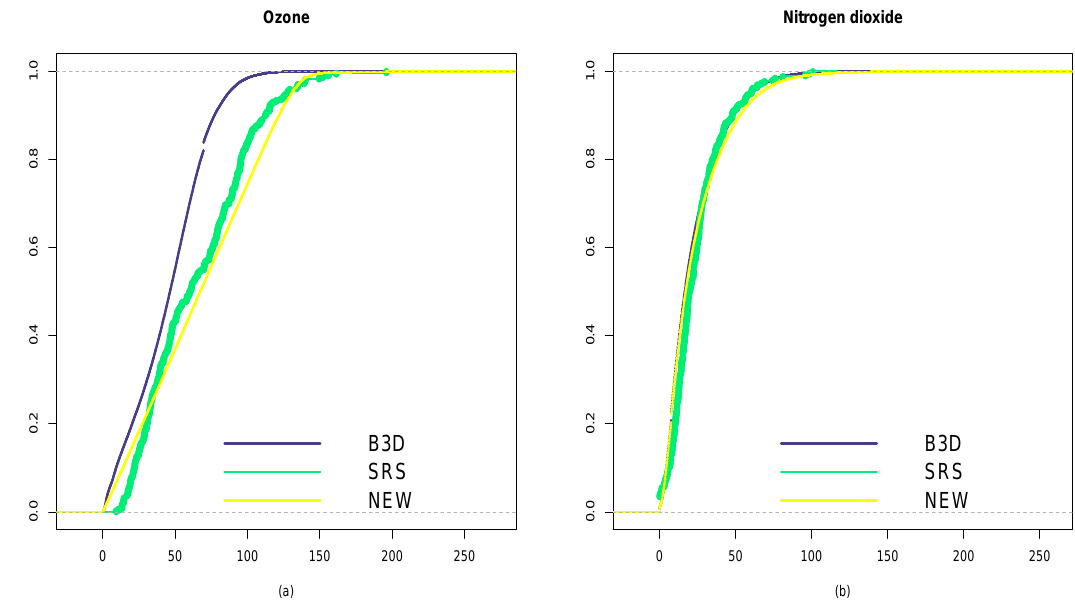
Figure 4. Estimated cumulative distribution functions involved in the case study with air quality data. ( a ) Empirical distribution function of the ozone level in the last 15 years (blue line), the analogue for temperatures greater than or equal to 30 ◦ C (green line) and the estimated distribution function using the proposed estimator (yellow line). ( b ) Empirical distribution function of the nitrogen dioxide level in the last 15 years (blue line), the analogue for temperatures greater than or equal to 30 ◦ C (green line) and the estimated distribution function using the proposed estimator (yellow